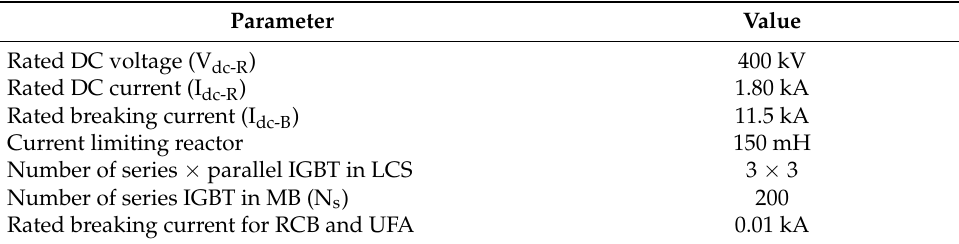
Table 2. Main Parameters of H-DCCB.